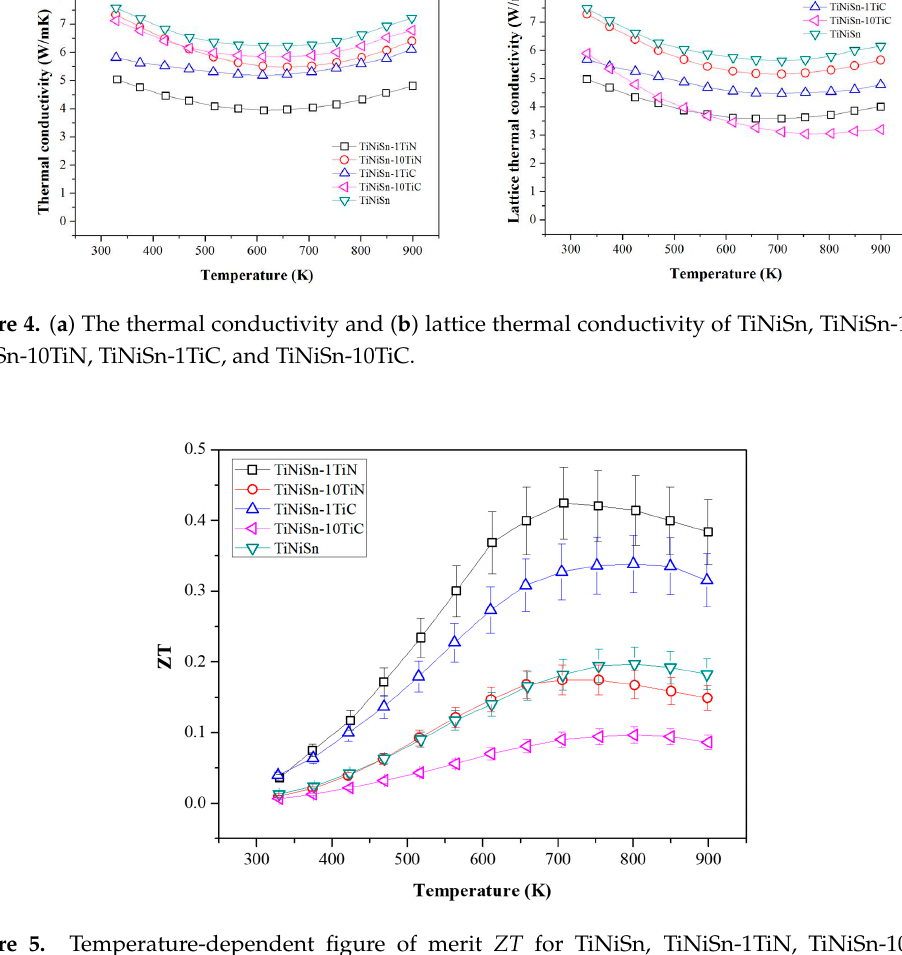
Figure 5. Temperature-dependent figure of merit ZT for TiNiSn, TiNiSn-1TiN, TiNiSn-10TiN, TiNiSn- 1TiC, and TiNiSn-10TiC.